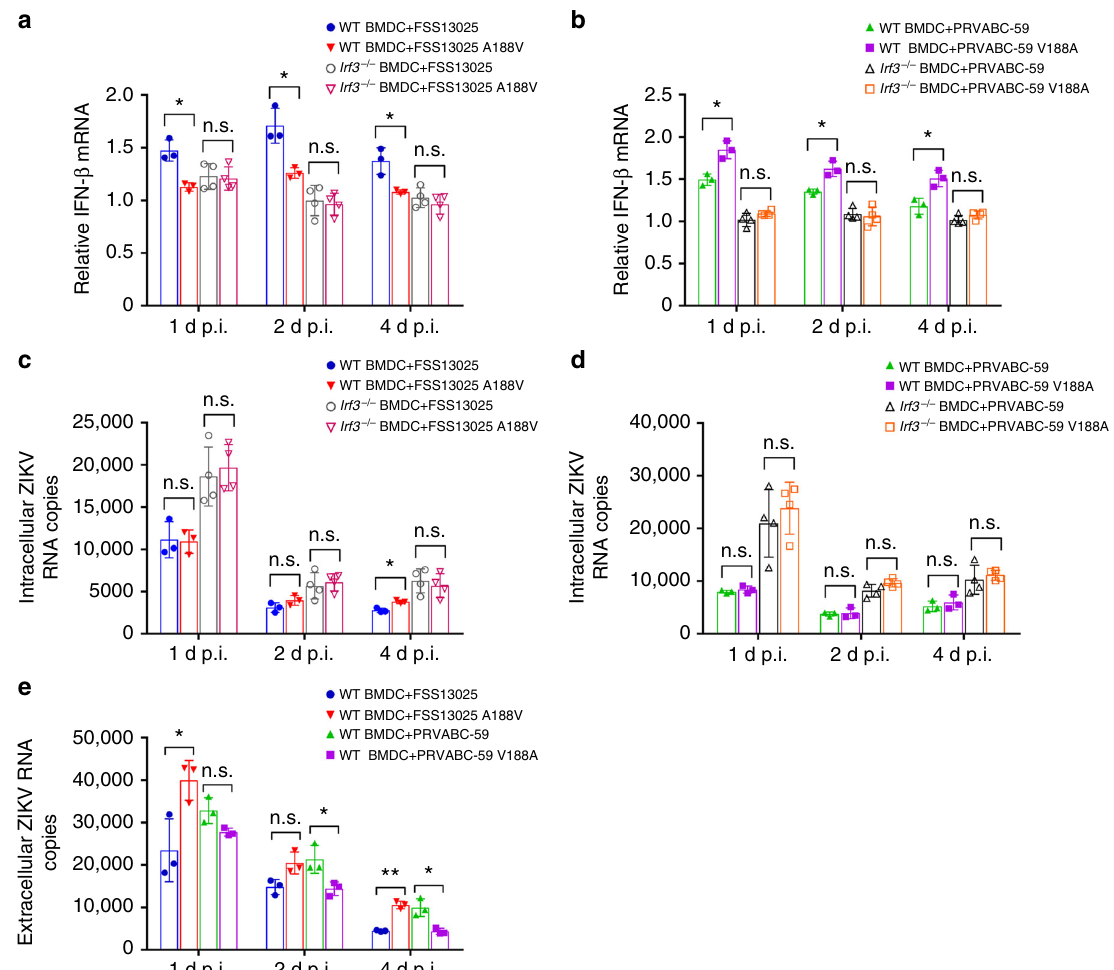
Fig. 6 The role of NS1 mutation in evasion of IFN- β production in primary dendritic cells. BMDCs from C57BL/6J mice or Irf3 − / − mice were infected with FSS13025 WT, FSS13025 A188V ( a ), PRVABC-59 WT, or PRVABC-59/V188A ( b ) at an MOI of 0.2. Cells were harvested and total intracellular RNA were isolated at days 1, 2, and 4 p.i., followed by qRT-PCR quanti fi cation of IFN- β mRNA ( a , b ) and intracellular viral RNA ( c , d ) as described in Fig. 5. e Extracellular viral RNA from C57BL/6J BMDC cells in ( a and b ) were measured by qRT-PCR. Data are presented as means ± SD from two independent experiments (with at least triplicates for each experiment). Statistical signi fi cance is presented as * P < 0.05, ** P < 0.01, or no signi fi cance (n.s.) using unpaired Student ’ s t-